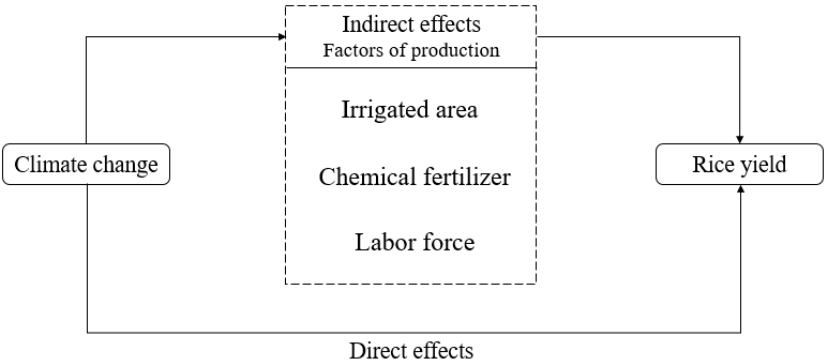
Figure 1. The hypothesized conceptual model. Source: Authors’ depiction.